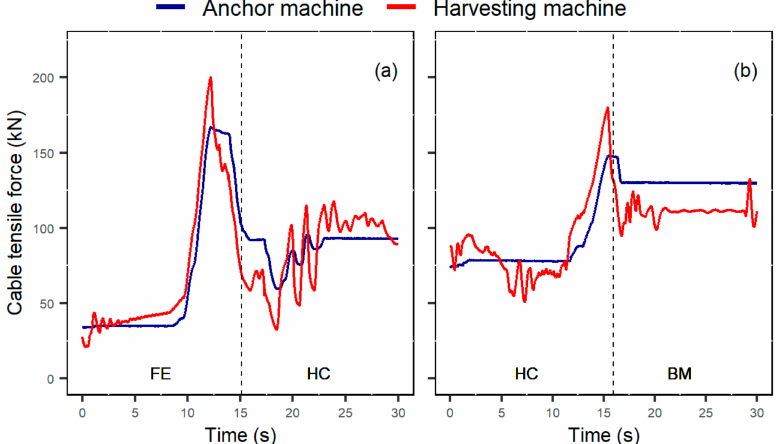
Figure 3. Example of significant events during stationary work elements: ( a ) Cable tensile force increment due to downhill-facing felling; ( b ) Cable tensile force increments due to downhill-facing hoe-chucking, bunching trees for the subsequent yarding operations. BM, other-boom-movements; FE, felling; and HC,